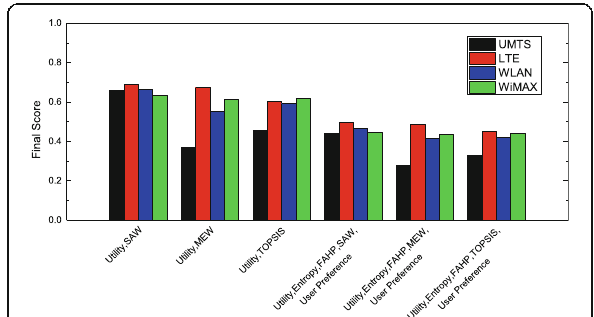
Fig. 11 Final scores of candidate networks for different algorithms for video application